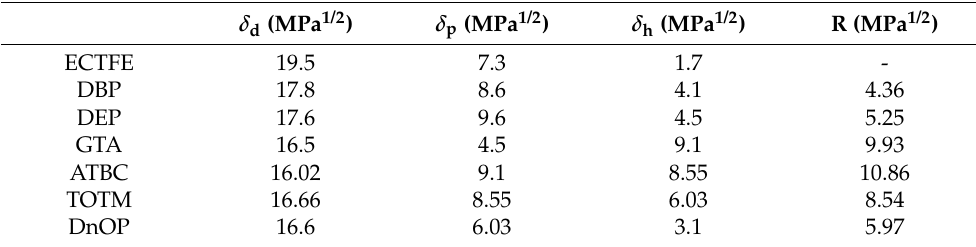
Table 4. Solubility parameters of ECTFE and diluents [17].